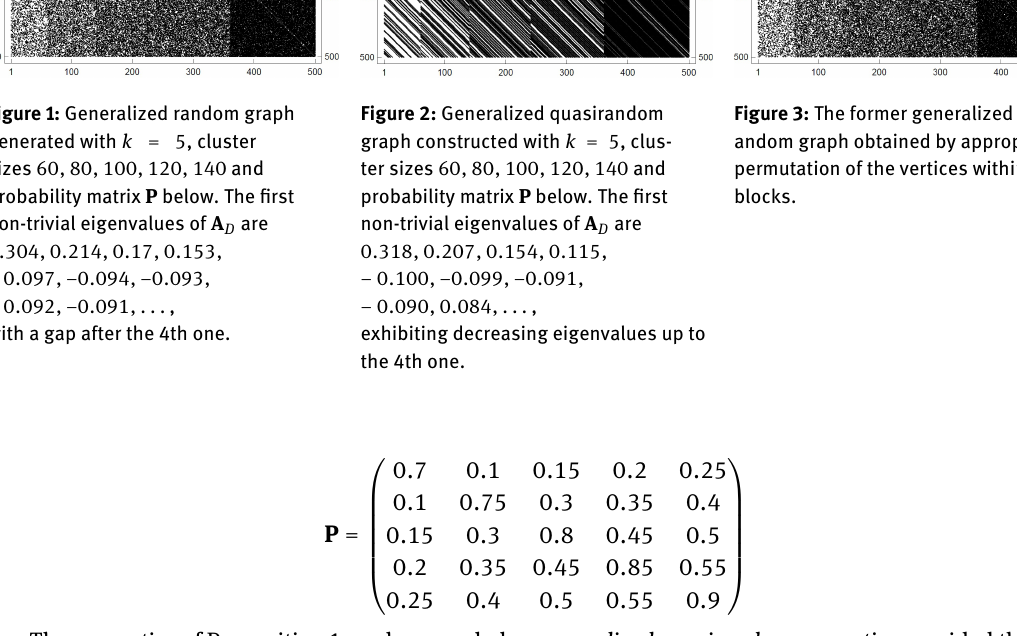
Figure 1: Generalized random graph generated with k = 5 , cluster sizes 60, 80, 100, 120, 140 and